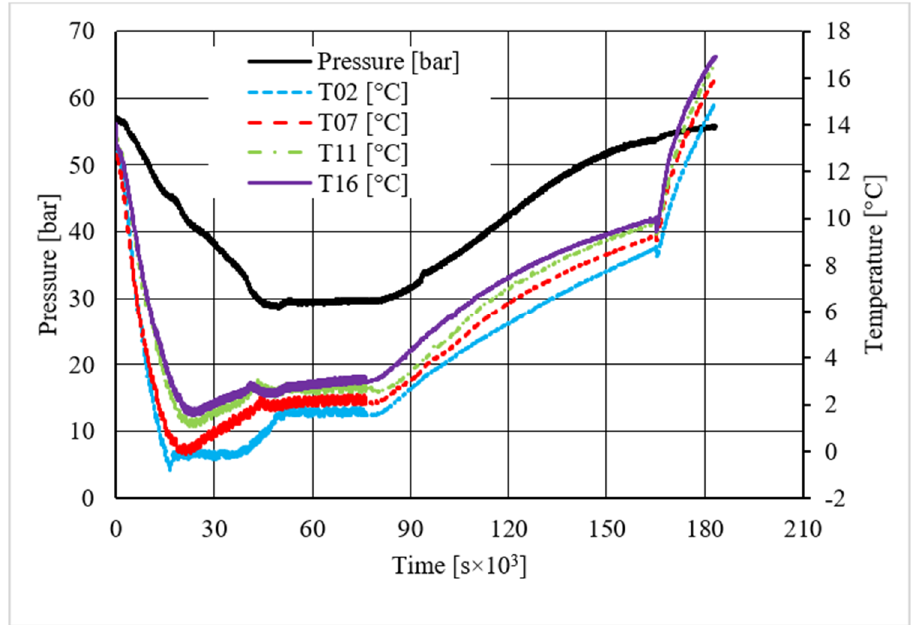
Figure 9. Pressure and temperature trends over time, measured for methane hydrate formation in presence of 18.01 wt% CuSn12 powder.